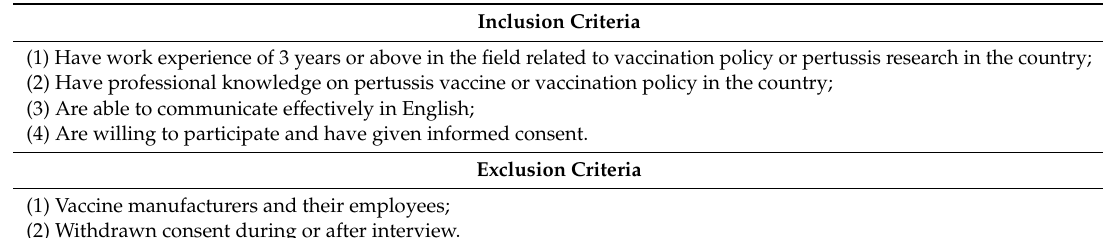
Table 1. Inclusion and exclusion criteria for participant